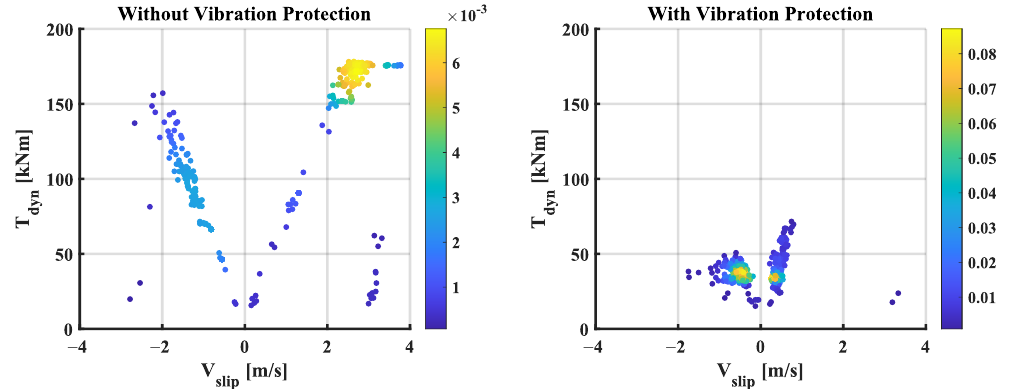
Figure 12. Simulation results. Dynamic torque vs. slip velocity with and without vibration protection during traction and braking, provoked by different adhesion scenarios.